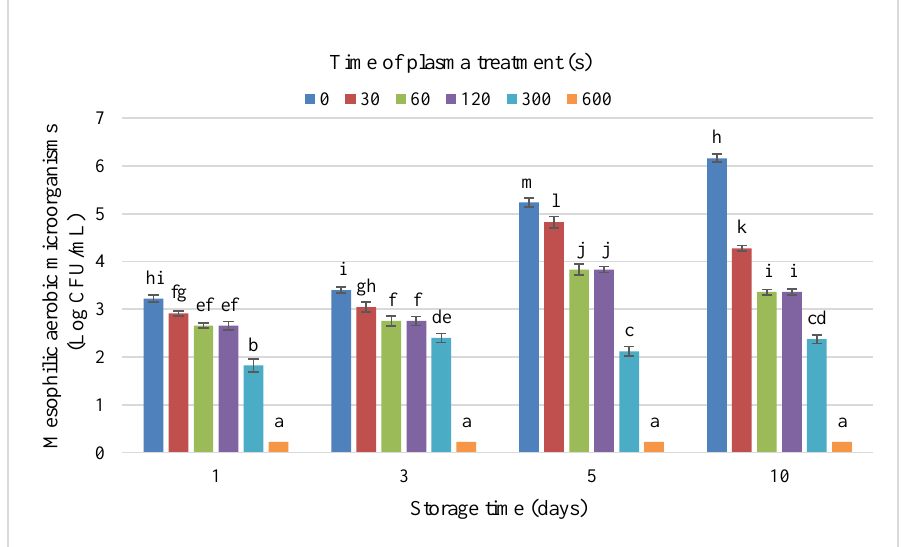
Figure 2. Number of mesophilic aerobic bacteria counts in control and CAP treated samples of unpasteurised tomato juice during refrigerated storage. Mean values ( n = 4) with SD are shown a–m—statistically significant differences between the means ( p < 0.05).